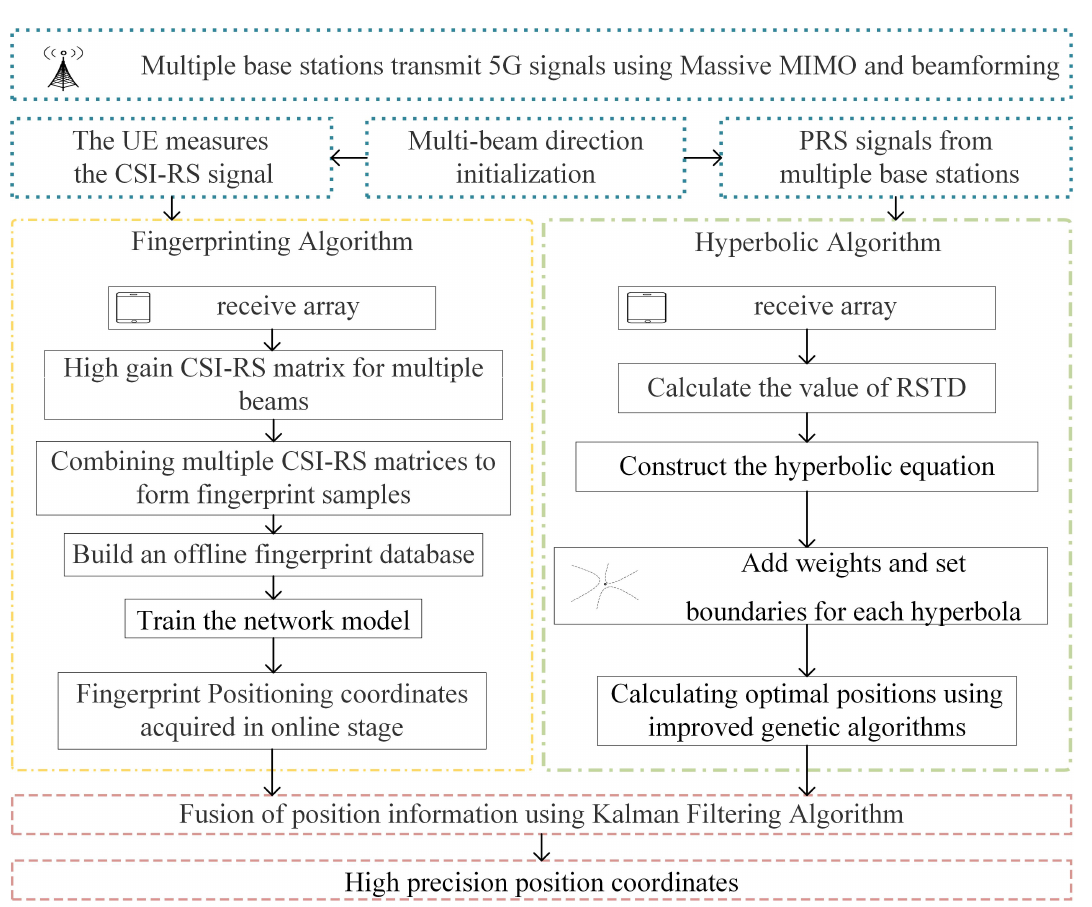
Figure 2. System flow